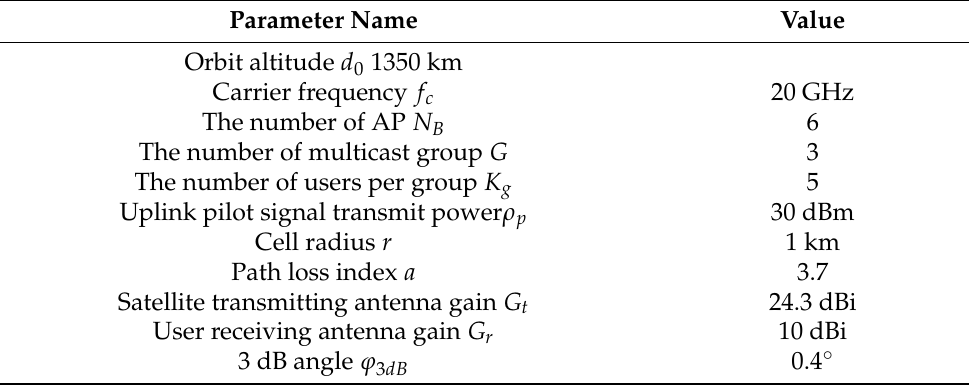
Table 1. simulation